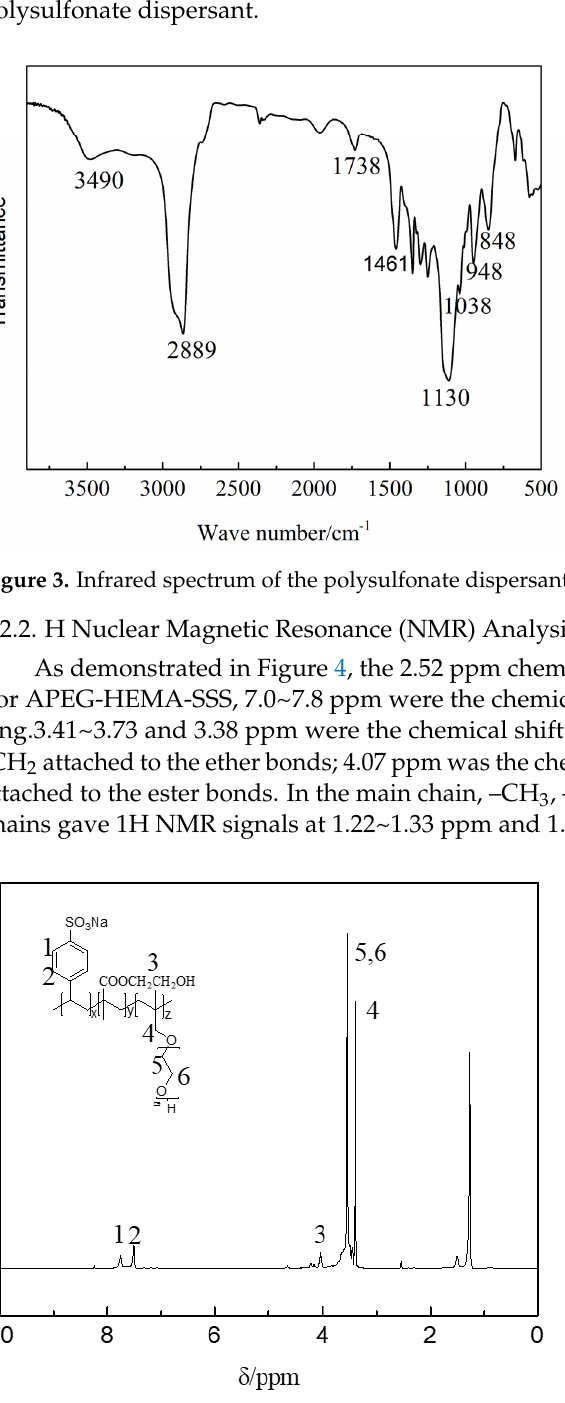
Figure 4. 1 H nuclear magnetic resonance (NMR) spectrum of the polysulfonate